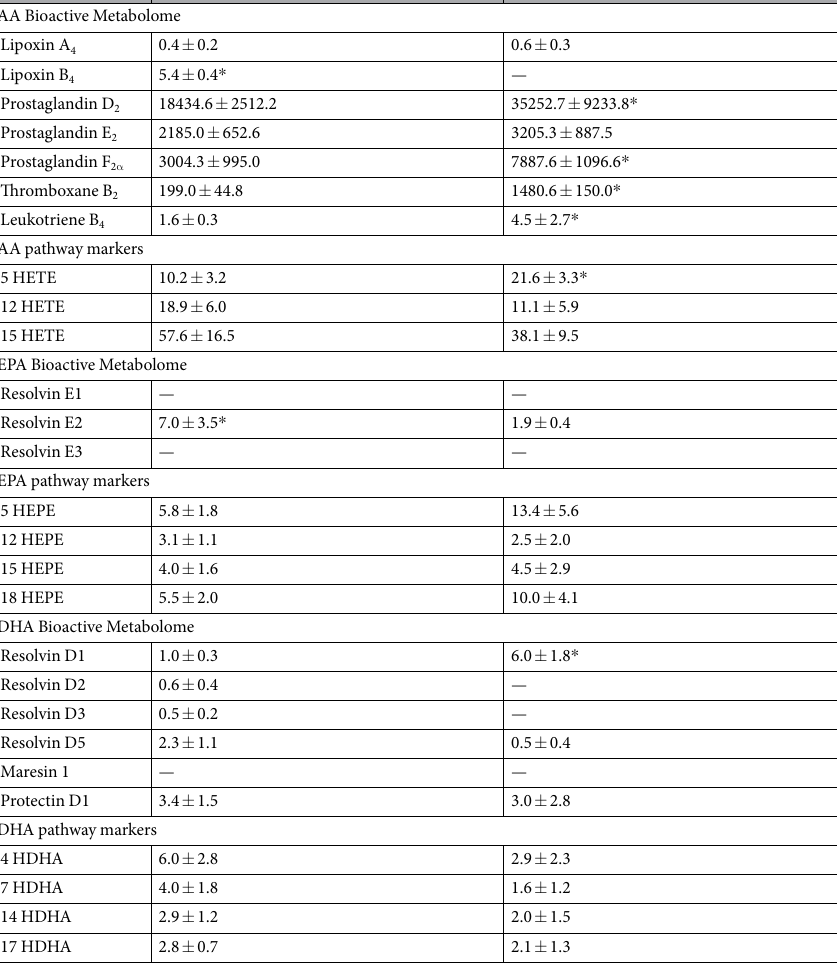
Table 1. Lipid mediator profiles of macrophages incubated with HDL Healthy or HDL CAD . — = below detection limits. Values were represented as mean ± SEM. * P < 0.05 between two